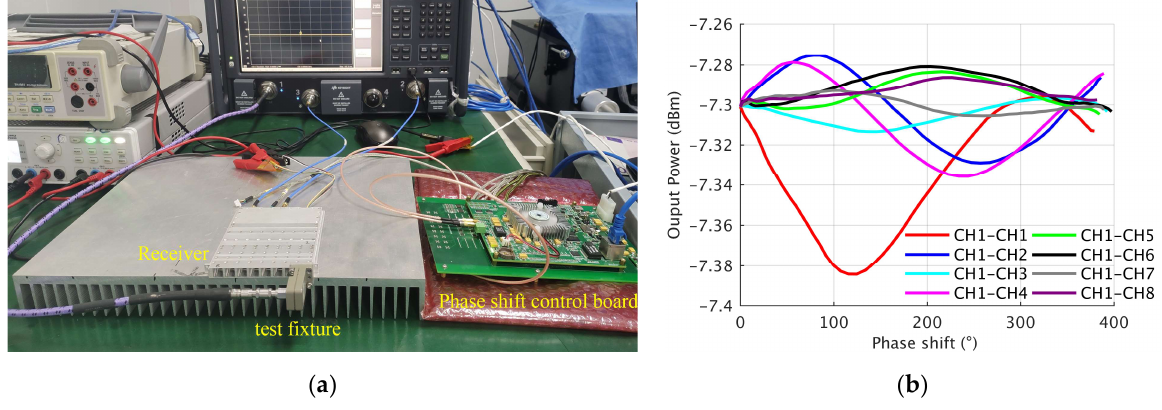
Figure 21. ( a ) The Channel mutual coupling measurement platform. ( b ) Changing curves of the output signal amplitude with phase shift. Table 1. Results related to channel mutual coupling.